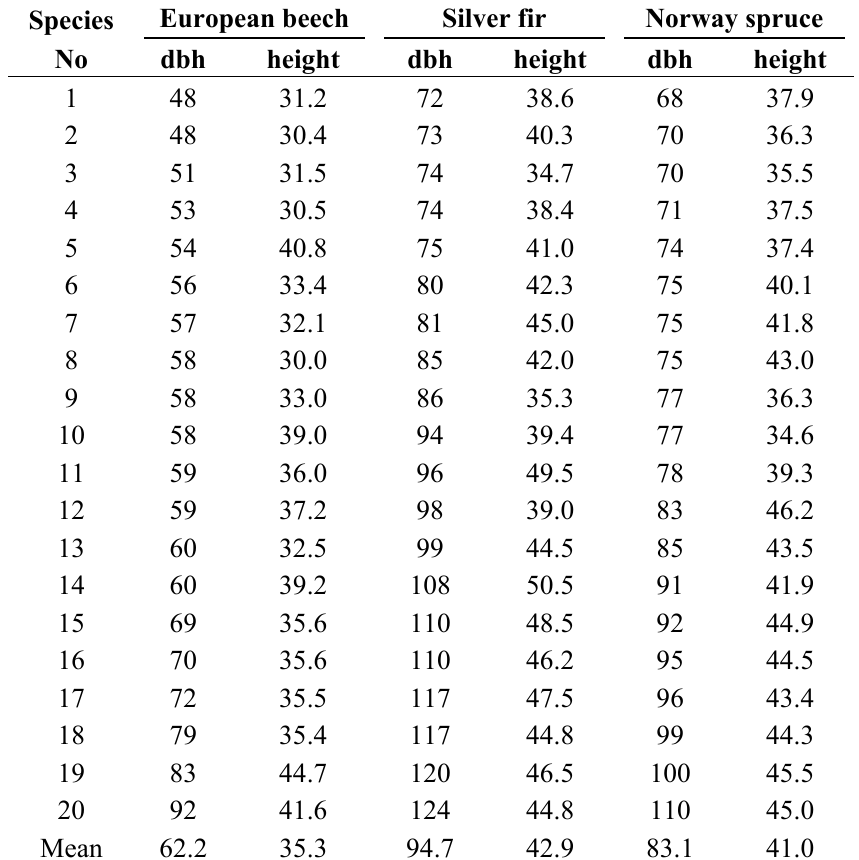
Table A1. Heights of thickest trees of major tree species in old-growth Janj. Species European beech Silver fir Norway